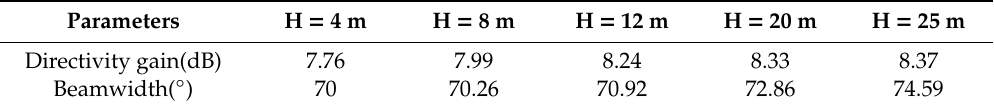
Table 4. The variation of the receiving antenna characteristics with the erection height.